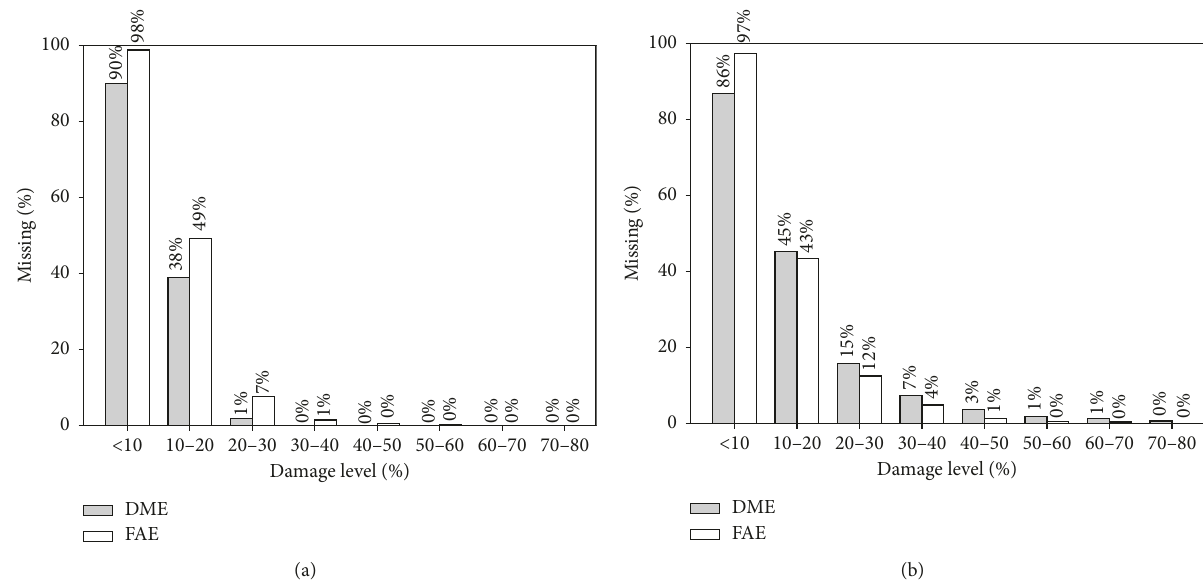
Figure 26: MLP’s DME and FAE versus damage level for the structural beam using (a) MLP 1 and (b) MLP 2.